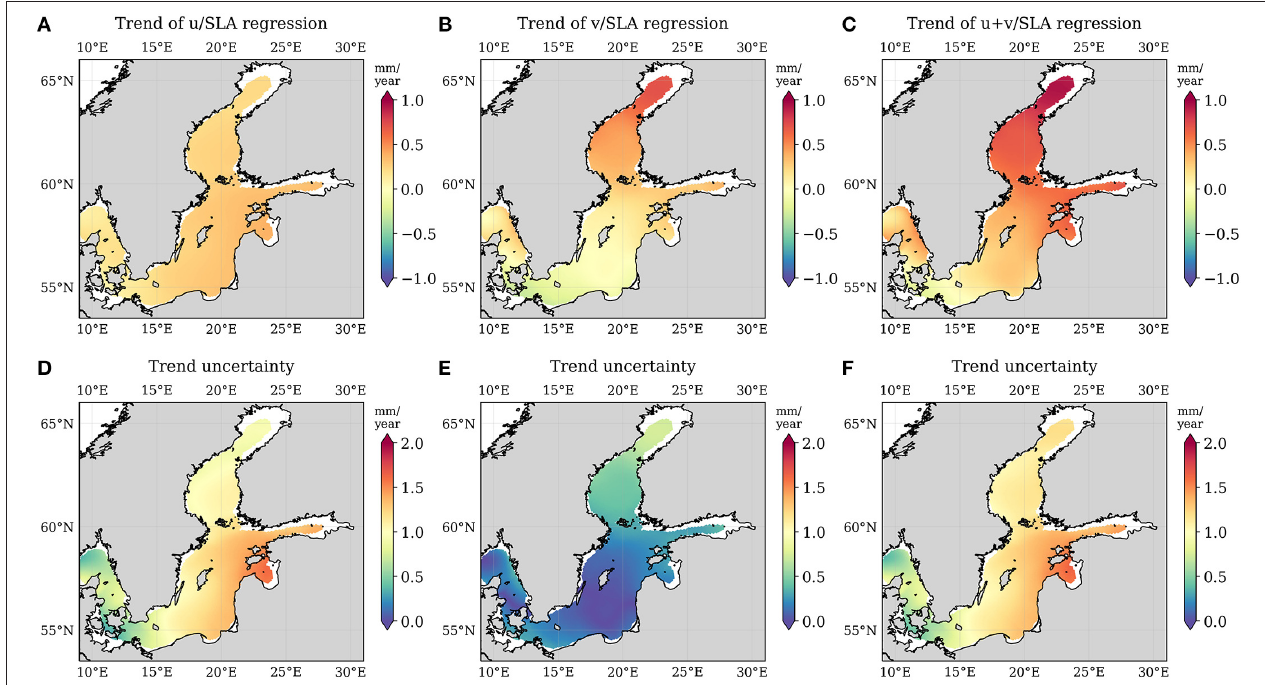
FIGURE 10 | Trends resulting from the regression of the zonal (U, A ) and meridional (V, B ) component of the surface winds on the SL time series. (C) Shows the trend obtained summing the two components of the regression. (D–F) Show the corresponding uncertainties of the respective trend estimations in (A–C)